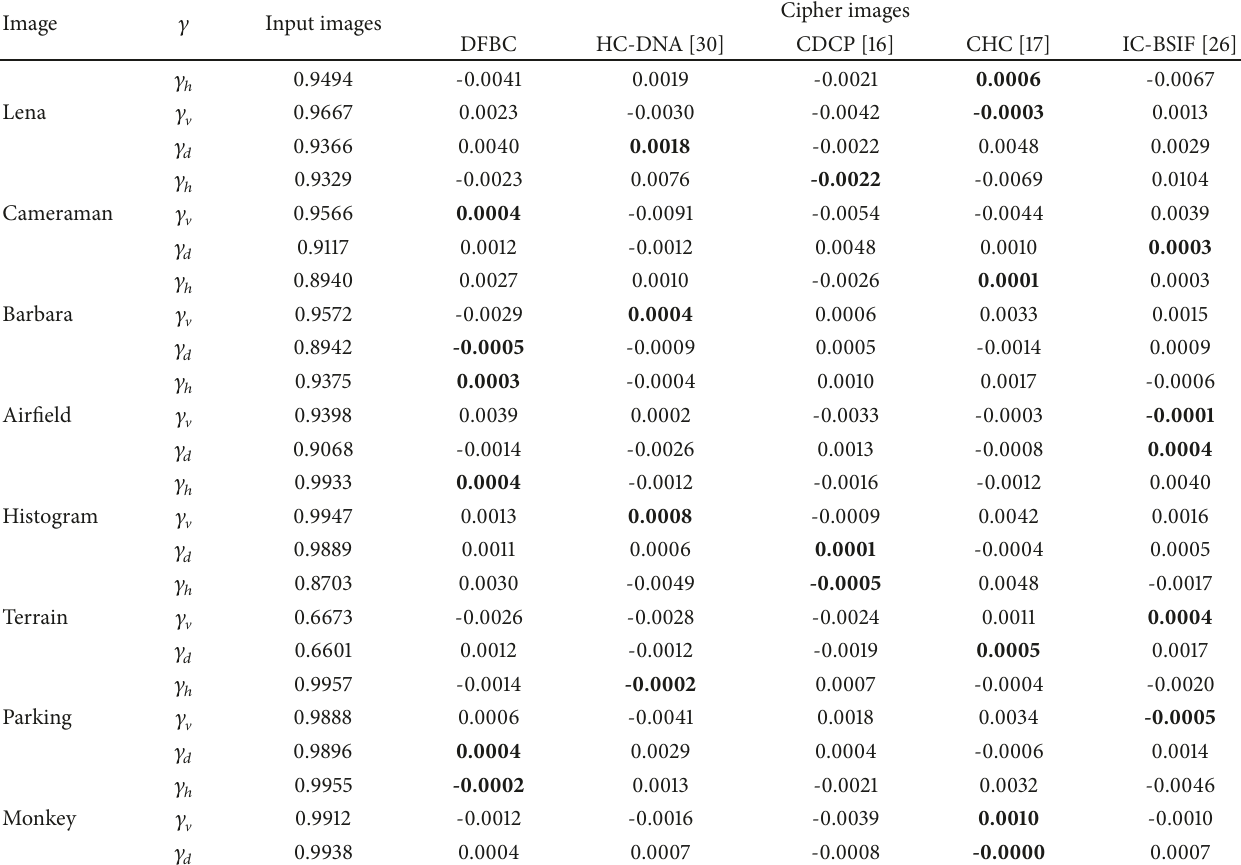
Table 3: The correlation coefficients 𝛾 of the testing